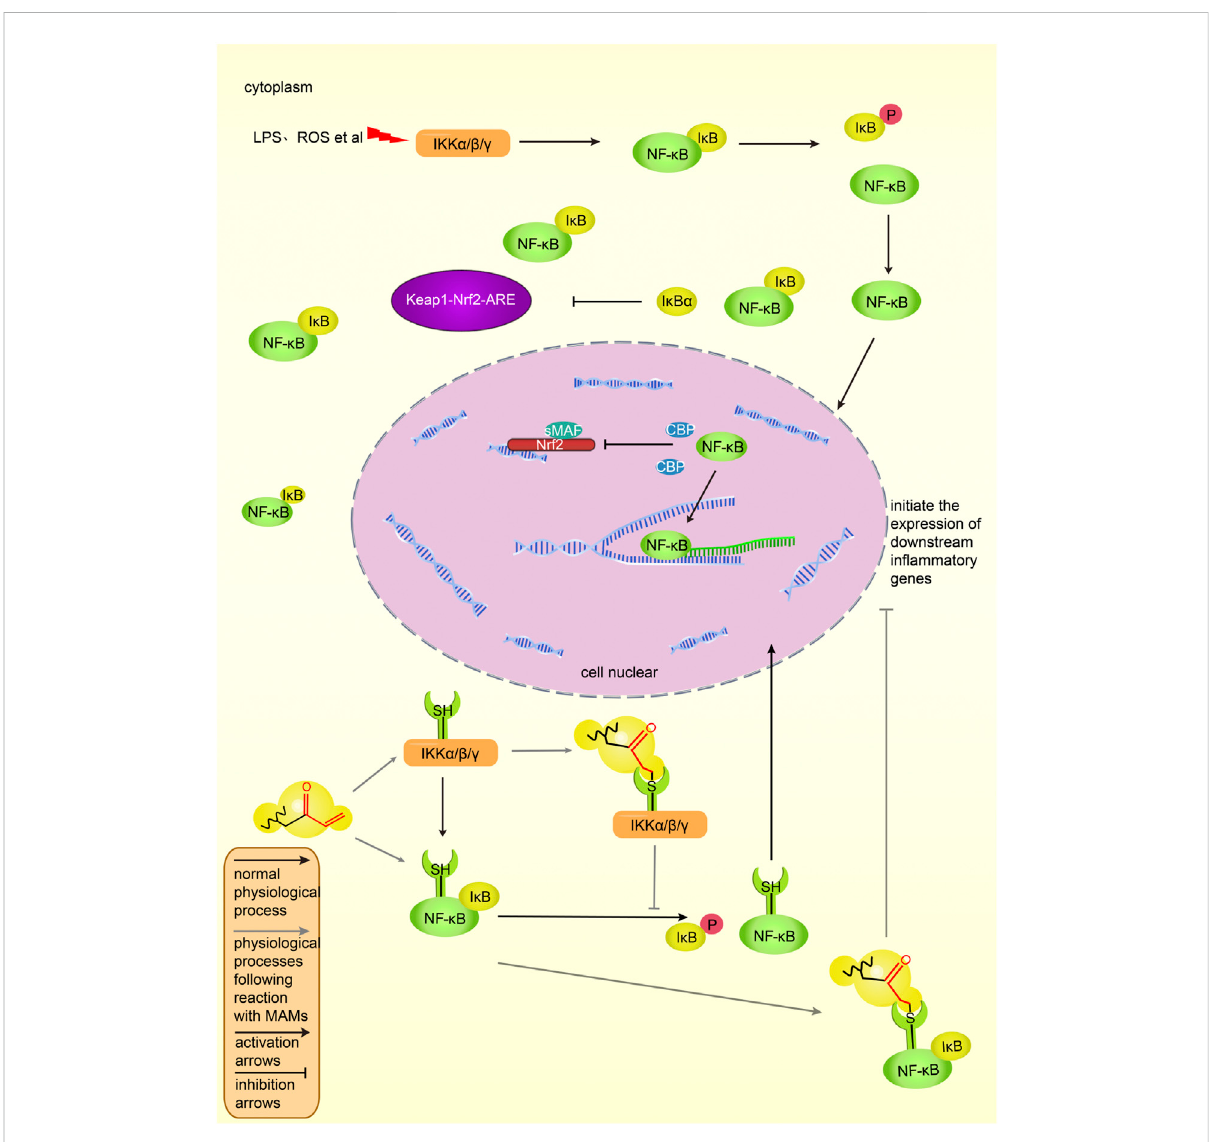
FIGURE 6 The NF- κ B pathway and its intersection action with Keap1-Nrf2-ARE in vivo . NF- κ B binds to I κ B and is in an inactive state in the cytoplasm. Under the stimulation of lipopolysaccharide and ROS, IKK phosphorylates I κ B, and NF- κ B dissociates from the complex, enters the nucleus, combineswiththecorrespondingDNAsequence,initiatesthetranscriptionofin fl ammatoryfactors,andinducesin fl ammation.I κ Bcanpromotethe activation of the Keap1-Nrf2-ARE pathway, and NF- κ Bcan prevent the binding of Nrf2 to CBP and inhibit the transcription of ARE genes. MAMs bindto cysteine residues oftheIKK complexorNF- κ B,inhibitingthedissociationofNF- κ BandI κ B,preventingNF- κ Bbinding toin fl ammatorygenes and inhibiting in fl ammatory factors expression. The black solid line represents the original process of in fl ammation in vivo , and the gray solid line represents the inhibitory process of MAMs on the NF- κ B pathway. Normal arrows indicate activation and T-shaped arrows indicate